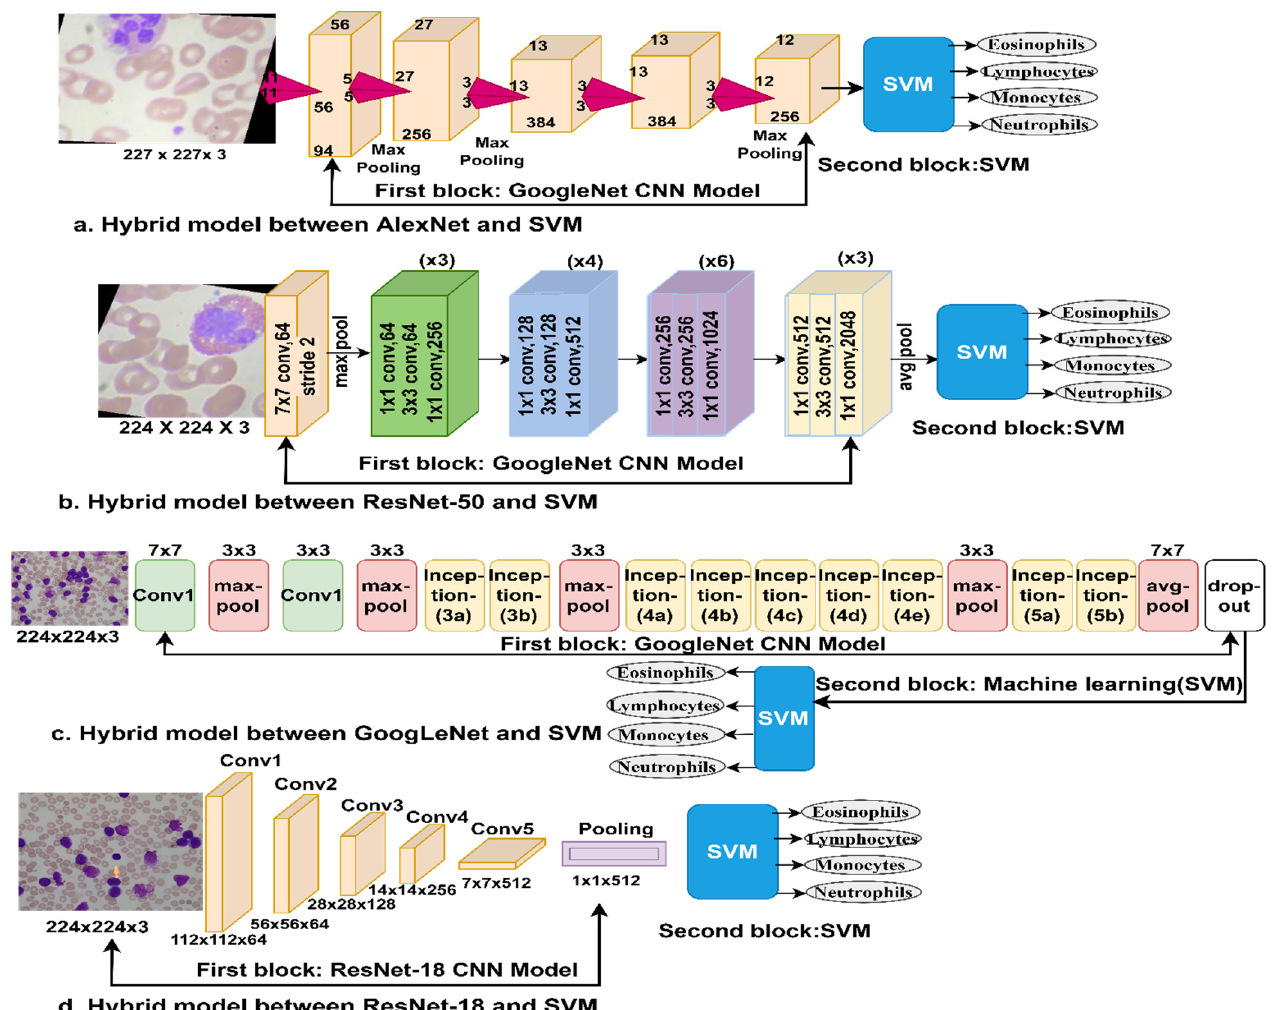
Figure 7. Hybrid method using CNN models and SVM. ( a ) AlexNet with SVM. ( b ) ResNet-50 with SVM. ( c ) GoogLeNet with SVM. ( d ) ResNet-18 with SVM.